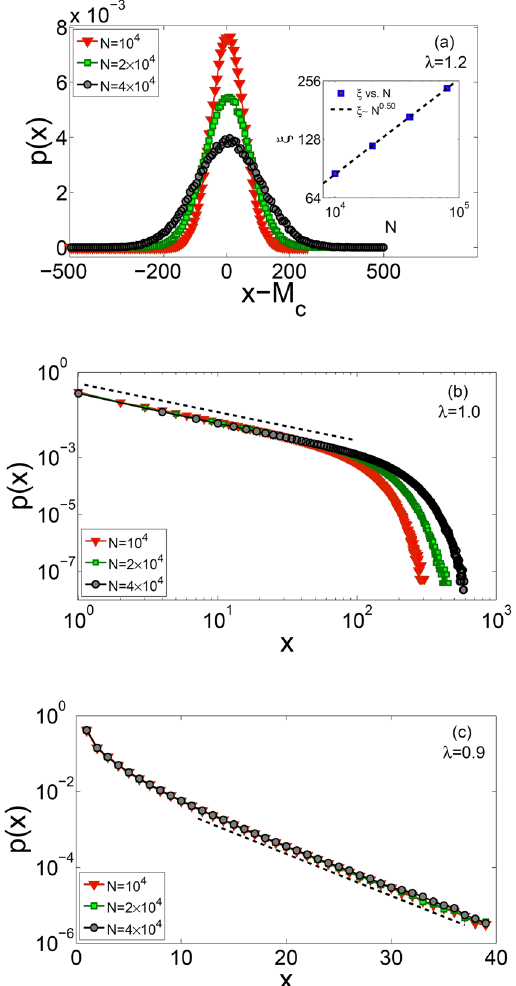
Figure 4. Probability distribution function of aggregate activity ( p ( x )) as a function of x for different values of N . Panel (a) is a linear plot showing a Gaussian function for λ = 1.2 with a maximum at x = x c = M c . Inset is a log-log plot of the standard deviation ξ versus N . Panel (b) is a log-log plot showing power-law behavior for λ = 1.0, and panel (c) is a semi-log plot with λ = 0.9 showing exponential